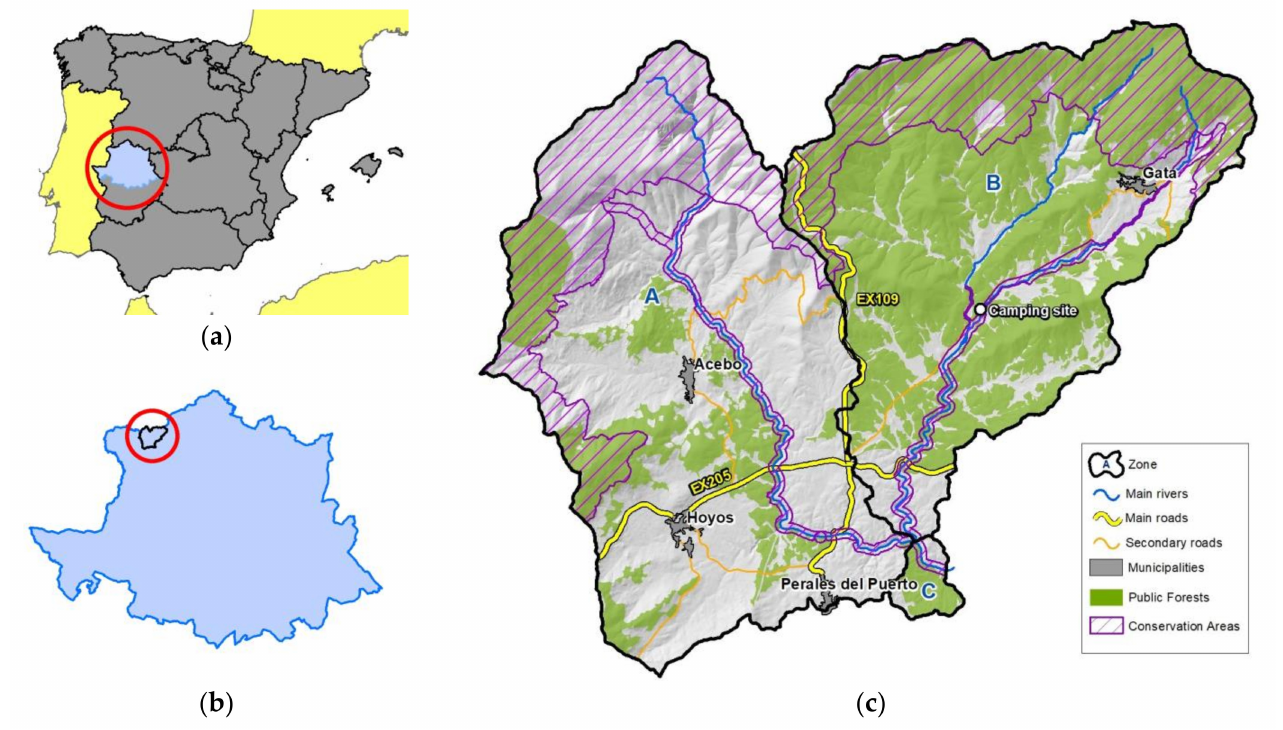
Figure 1. Overview of the study site: ( a ) C á ceres province; ( b ) location within C á ceres province; ( c ) study